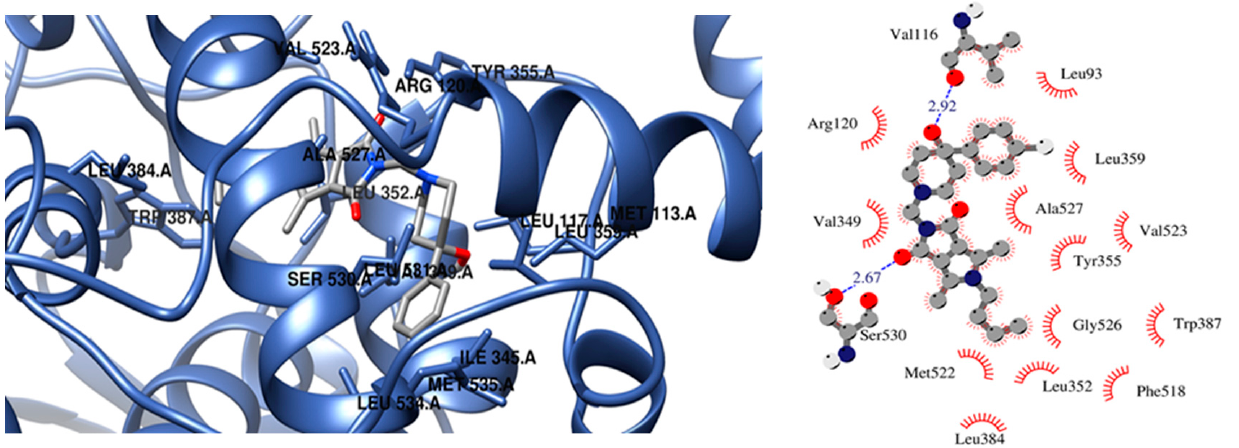
Figure 6. Configuration in the binding site of COX-2 for compounds 2o . Compound 2d forms hydrogen bonding three hydrogen bonds with Lys360, Asp352,